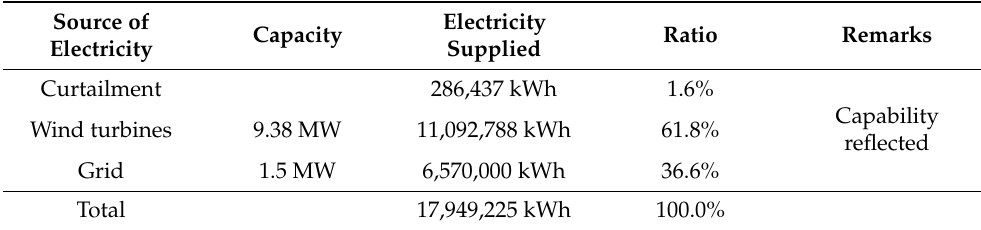
Table 37. The annual amount of electricity with the enhancement in wind power capacity.